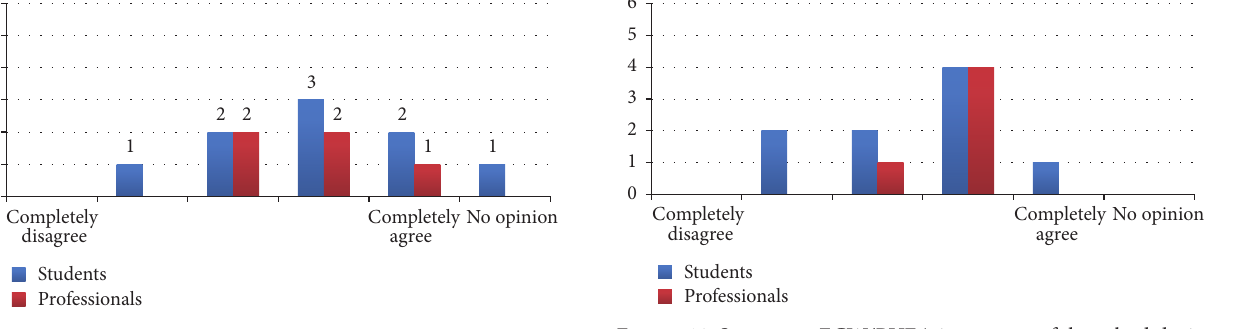
Figure 12: Statement: ECW/PUEA is a method well worth using.